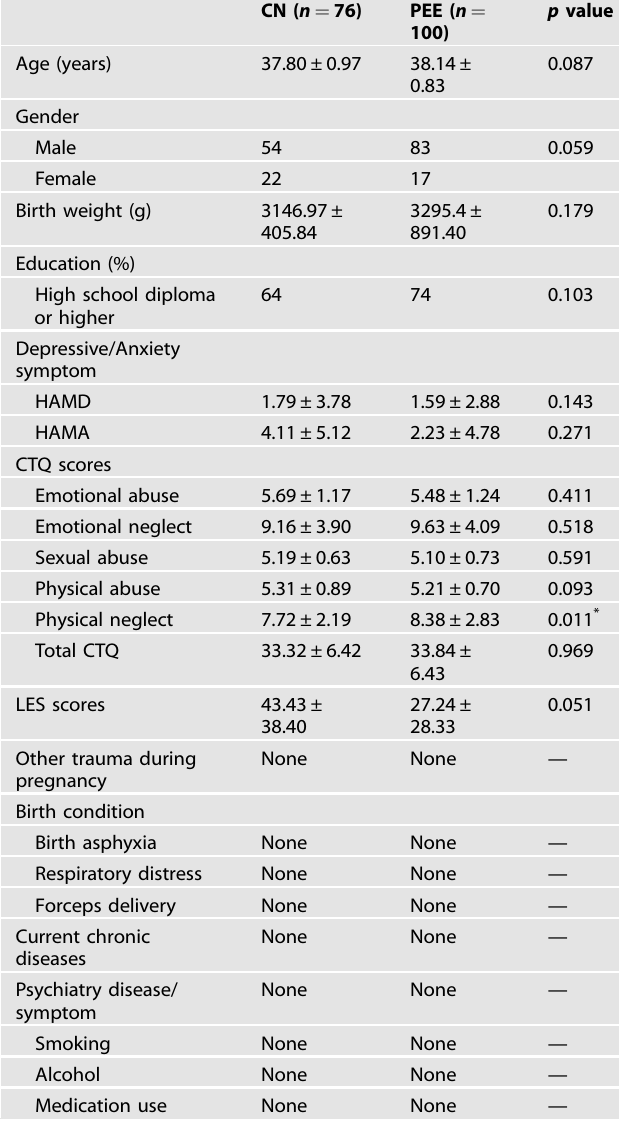
Table 1. Demographic